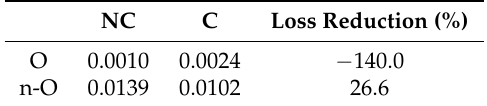
Figure 6. Output variables. Table 8. Losses under asymmetric